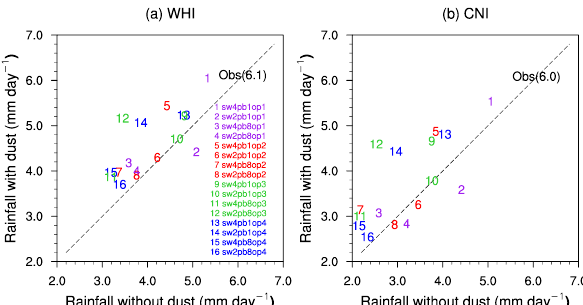
Figure 8. Scatter plot of area-averaged rainfall (mmday − 1 ) in WHI and CNI in 16 pairs of ALLF and NDST ensemble simulations and observations. “Obs” means averaged observational rainfall from TRMM, GPCP, and CMAP, with area-averaged mean values of 6.1 and 6.0 in parentheses in WHI and CNI, respectively. The ensemble numbers are the same as in Fig. 7. See Table 2 for the denotations.